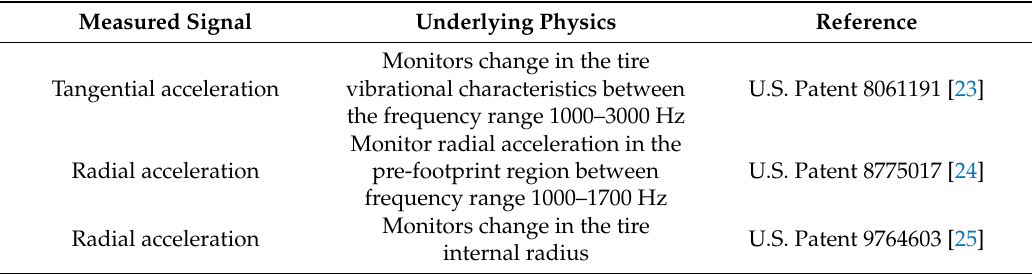
Table 3. Proposed techniques for tread depth estimation using tire mounted